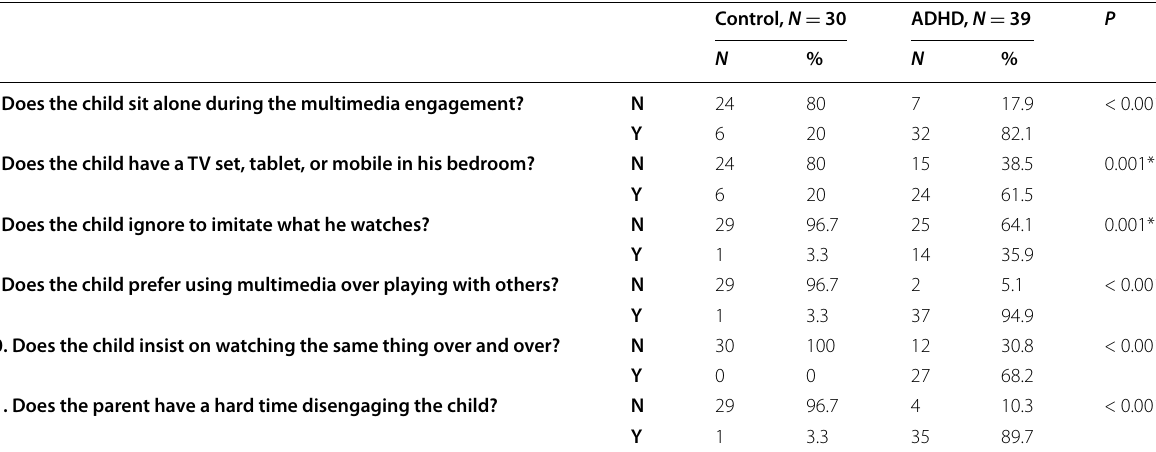
Table 4 Descriptive and comparative analysis between the studied groups regarding the answers of the constructed